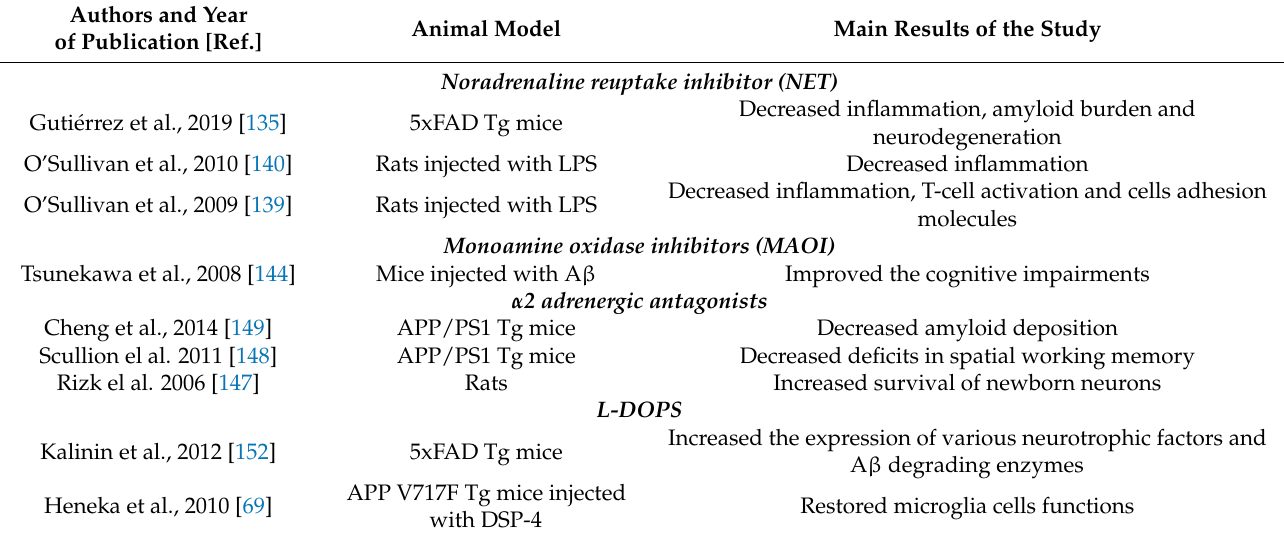
Table 3. Targeting noradrenergic system in preclinical